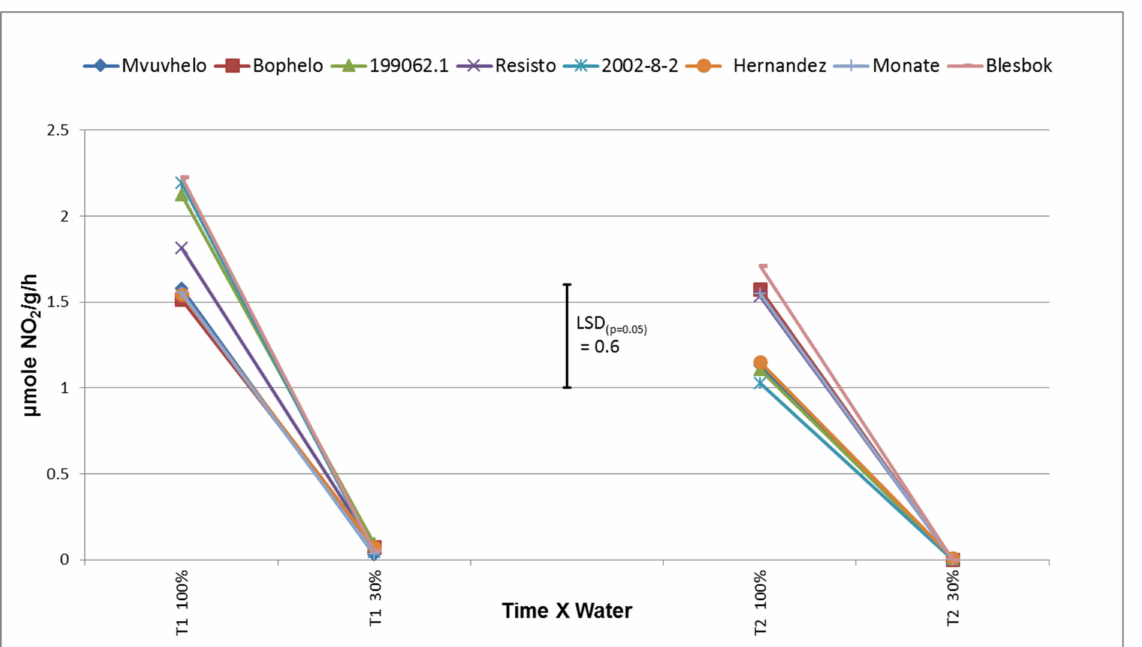
Figure 5. Activity of nitrate reductase (NR) enzyme displayed through the amount of NO 2 consumed in eight sweet potato cultivars as a result of drought stress. LSD planting; T2 = 120 days after planting. 100% = control treatment, 30% = severe stress